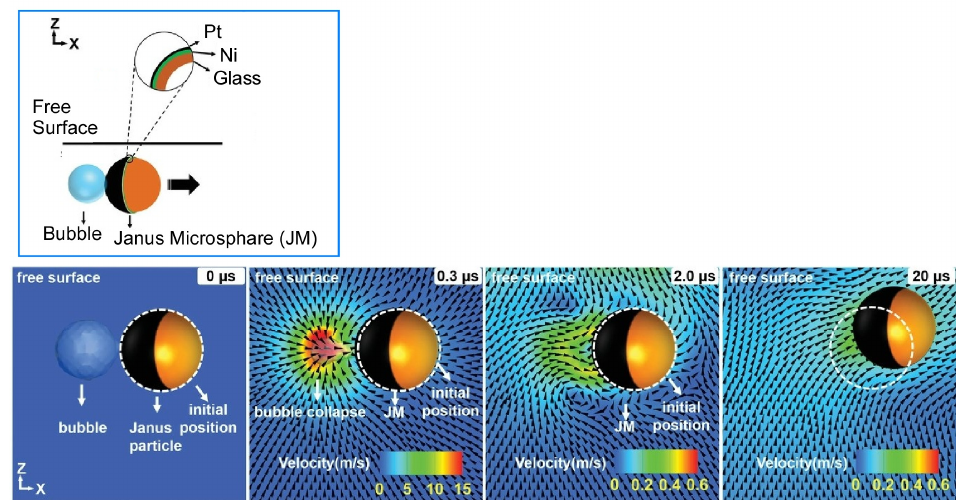
Figure 26. The bubble microrobot consists of hollow Janus microspheres controlled by a magnetic field with switching between working modes: pusher, gripper, anchor, and sweeper through operating mechanism of collapse of bubbles and the control of induced jet flow through the air-liquid interface. Reprinted with permission from Reference [205]. Copyright 2022 Wiley-VCH.